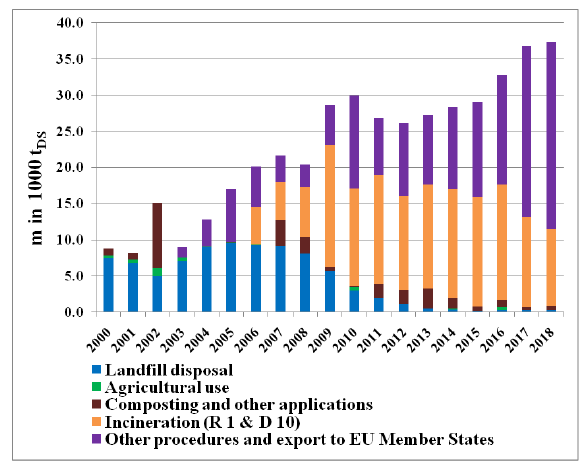
Figure 1. Generation and management